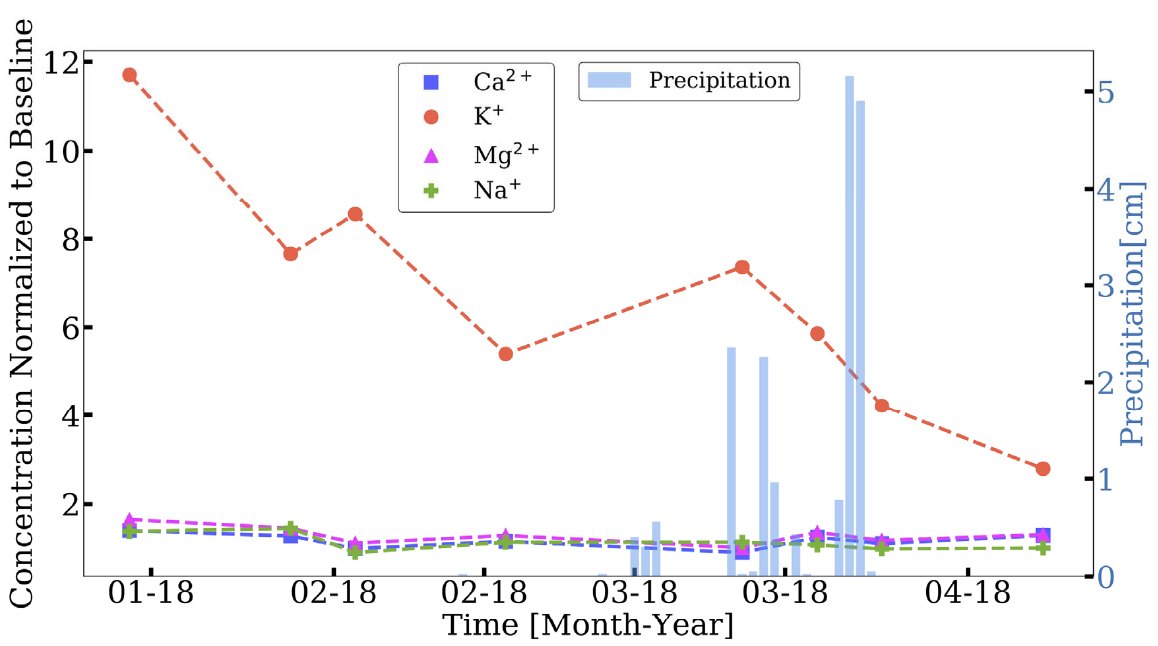
Figure 4. Major cation concentrations at Upper El Cap (East Fork) site following the first major precipitation event for the season, normalized to (divided by) the mean pre-storm baseline